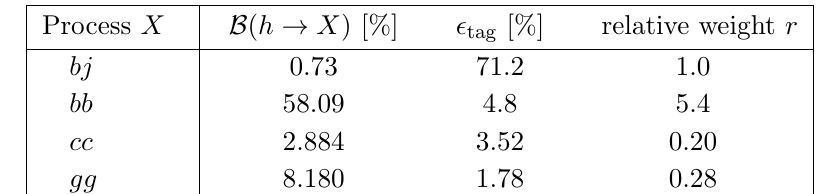
Figure 2. Left : expected 95 % CL exclusion and 5 (cid:27) discovery reaches on channel at p s = 250 GeV as a function of the total integrated luminosity for the two polarisation scenarios described in the text. Right : expected exclusion reaches for the four possible polarisation con(cid:12)gurations individually. Both plots assume (cid:15) syst = 1 %.